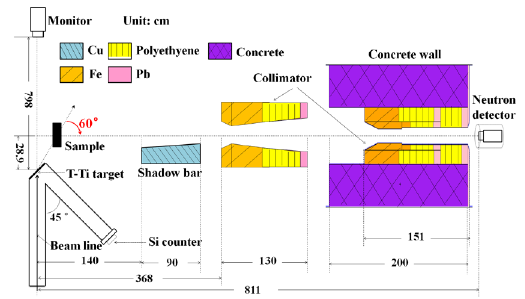
Figure 1. A schematic view of the experimental arrangement.